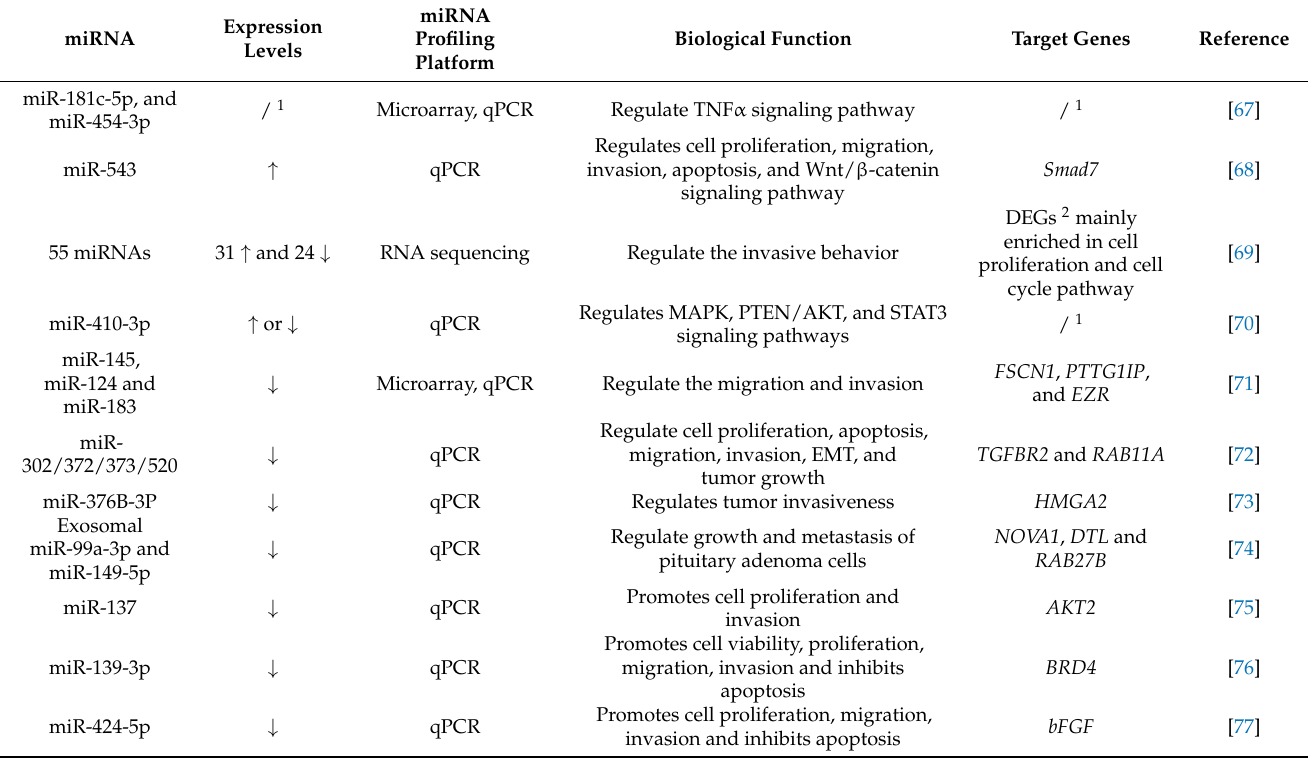
Table 6. Summary of differentially expressed miRNAs with their validated targets in invasive pituitary adenomas.